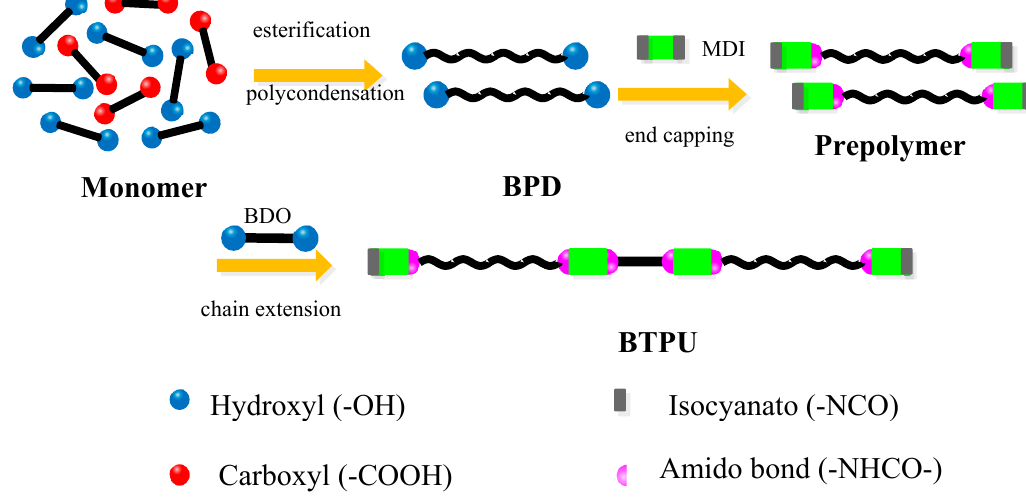
Figure 1. Schematic illustration of biodegradable thermoplastic polyurethane (BTPU) formation. Table 1. Compositions of various biodegradable thermoplastic polyurethanes (BTPUs).